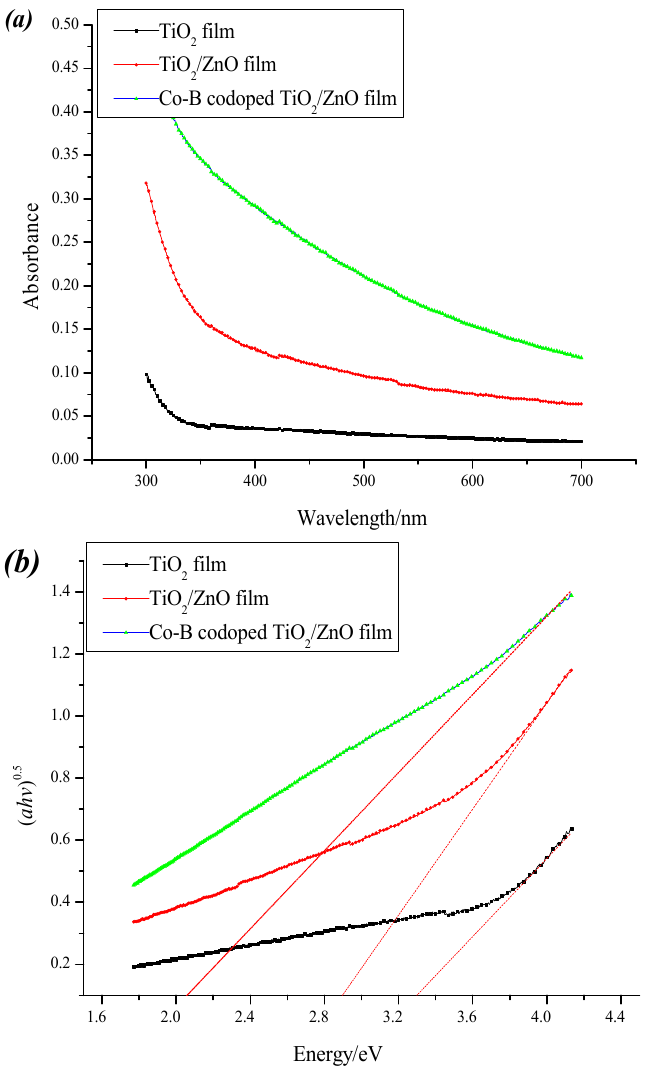
Figure 5. UV–Vis absorption spectra ( a ) and the band gap ( b ) of pure TiO 2 , composite TiO 2 /ZnO, and Co-B codoped TiO 2 /ZnO films. Co-B codoped TiO 2 /ZnO